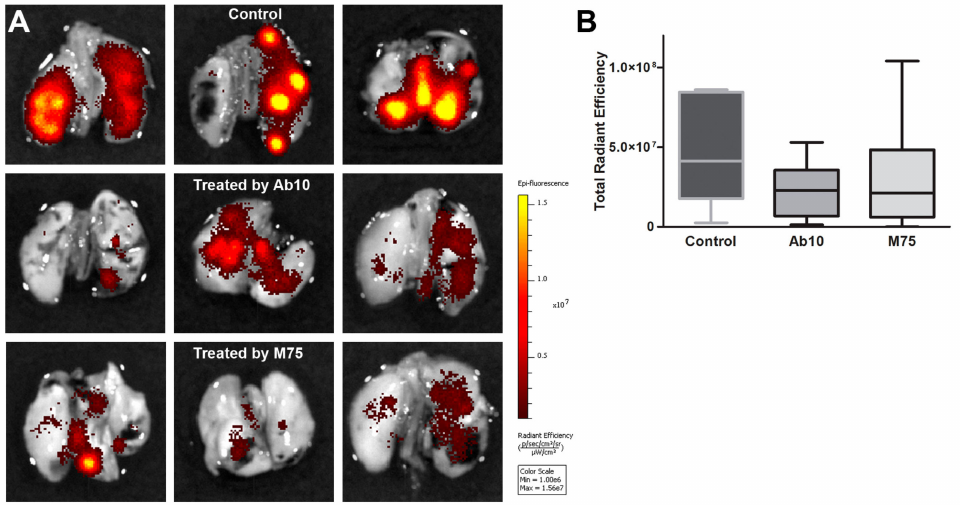
Figure 6. Treatment with CAIX-targeting antibodies prevents extensive lung metastasis formation during in vivo colonization assay. ( A ) Representative ex vivo images of fluorescent lung metastases of control mice (top panel), of mice treated with Ab10 antibody against the catalytic domain of CAIX and mice treated with M75 antibody against CAIX proteoglycan domain. Ex vivo imaging was performed 12 days after inoculation of RFP-labeled HT1080 cells using IVIS Caliper. Di ff erent stages of lung infiltration by HT1080-RFP cells correspond to the intensity and extent of the fluorescent signal. Scale of fluorescence intensity is shown on the right side of the picture with yellow color representing the strongest emission. ( B ) Box plot graph shows signal distribution of all analyzed lungs based on total radiant e ffi ciency values. Higher total radiant e ffi ciency values mean higher number of